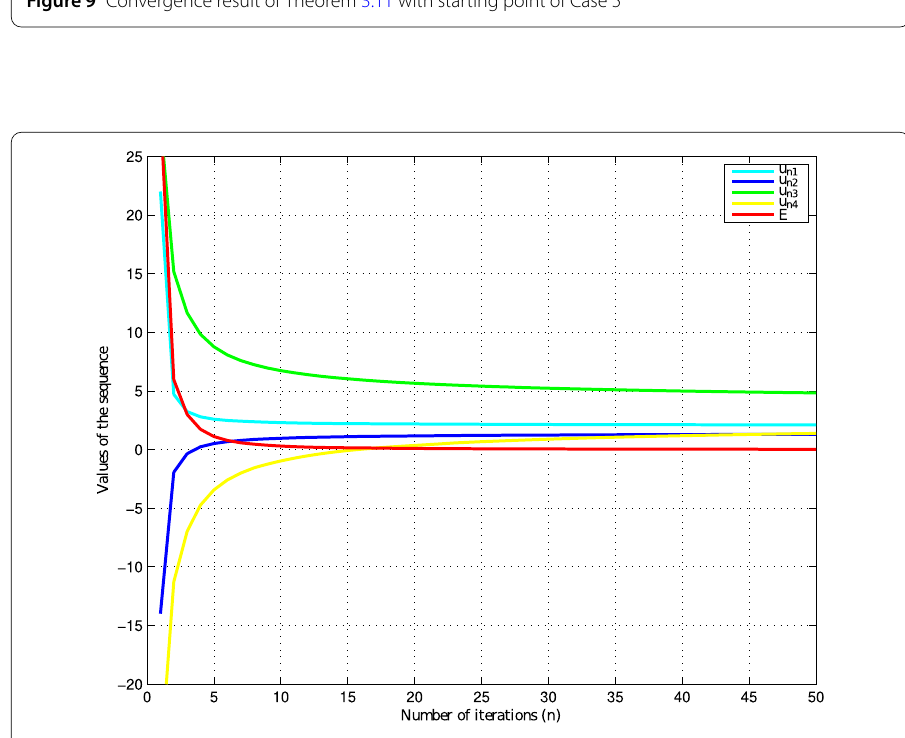
Figure 10 Convergence result of Theorem 3.11 with starting point of Case 6